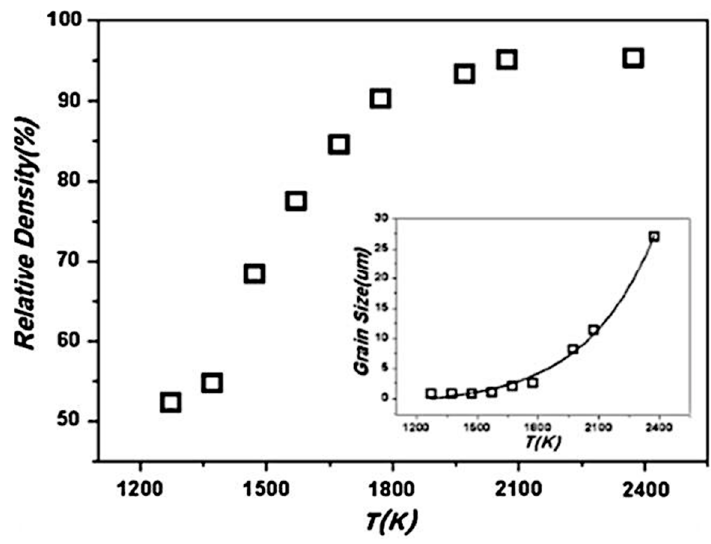
Figure 10. Densification curve of tungsten with various temperatures [44].